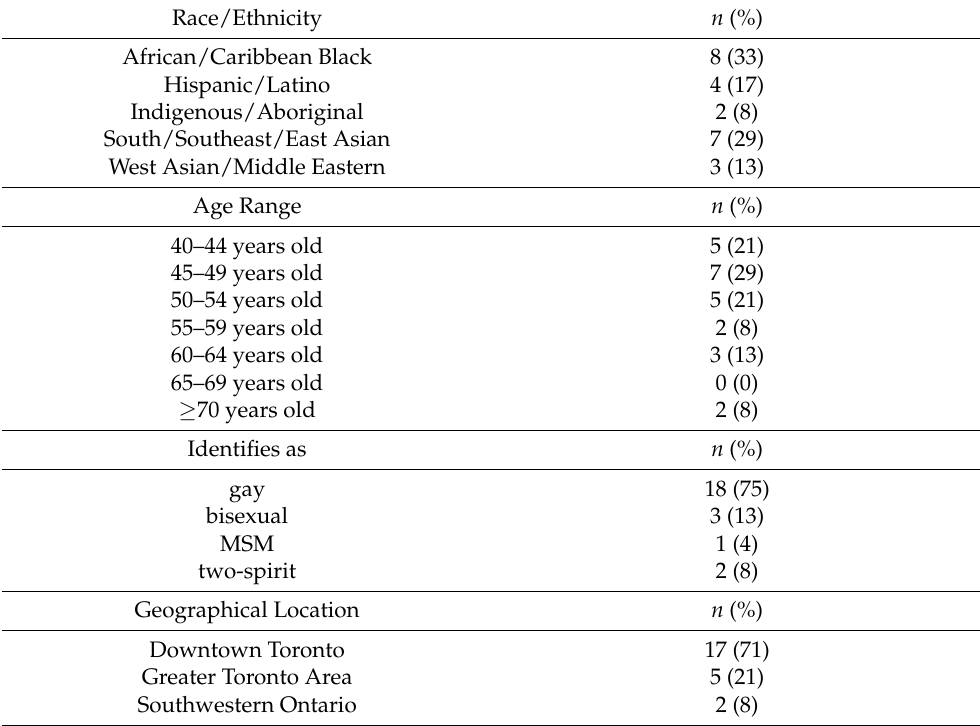
Table 1. Participant sociodemographics ( n =